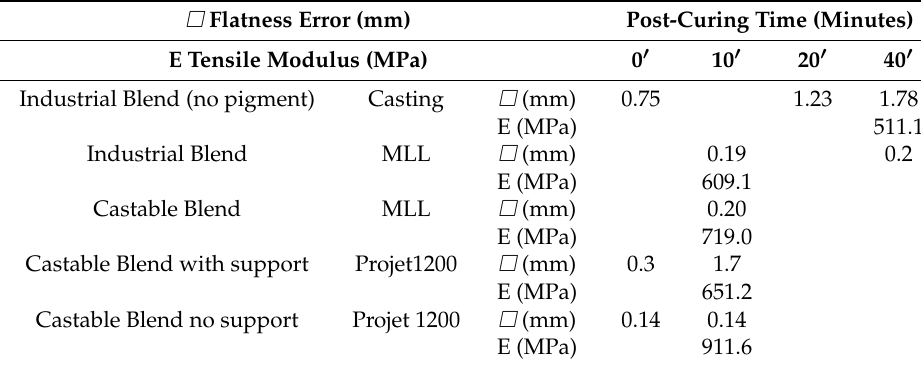
Table 2. Tensile modulus and flatness error under different post-curing times.